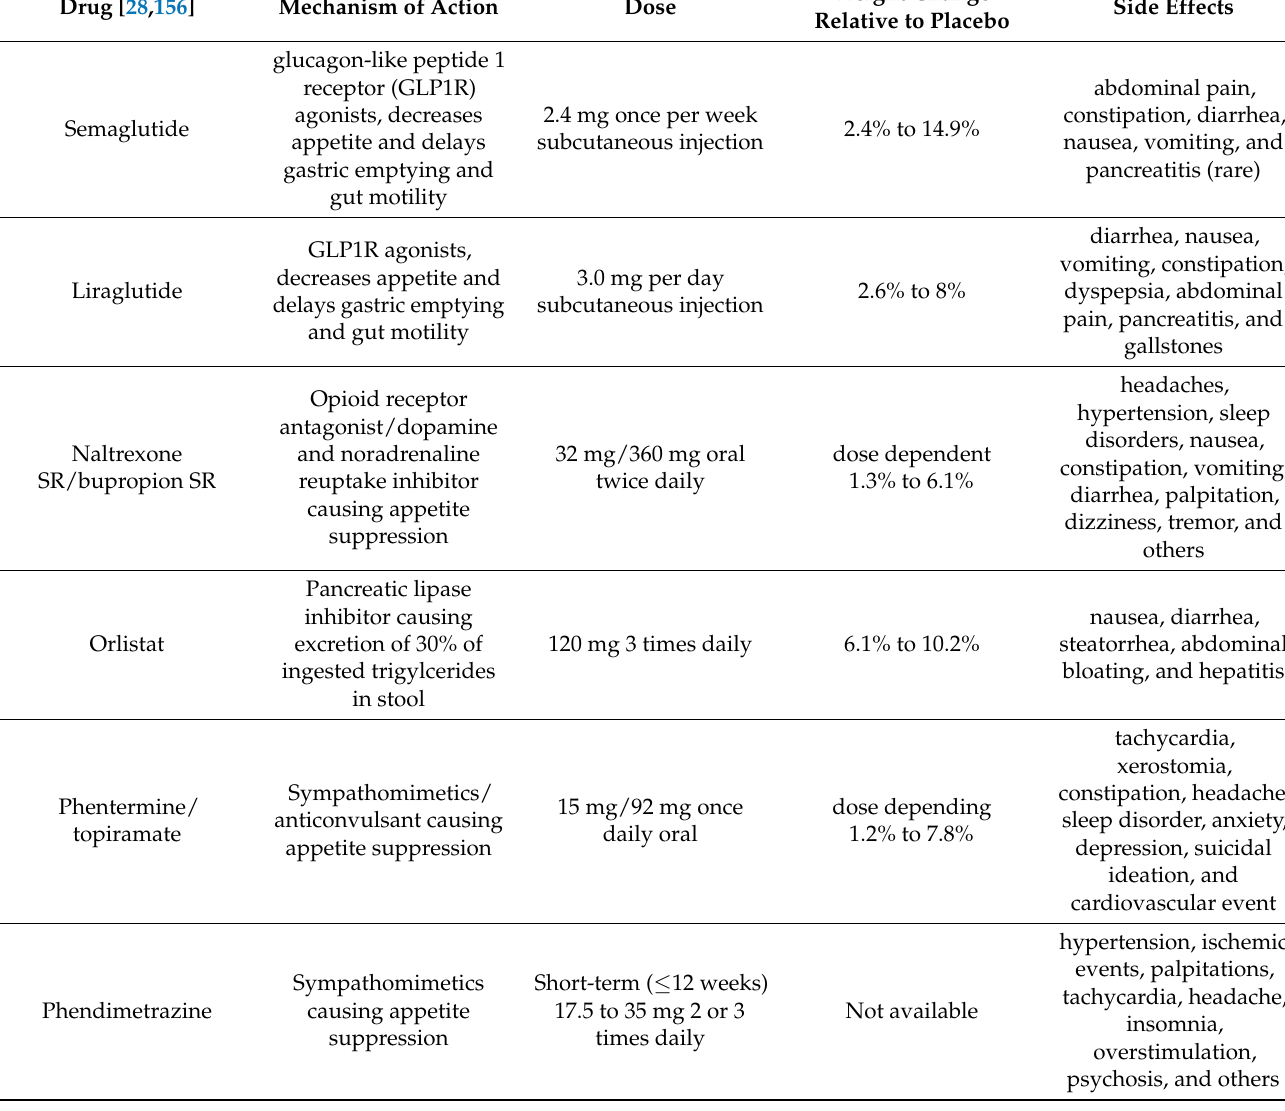
Table 4. Drugs with US Food Drug Administration (FDA) approved indication for